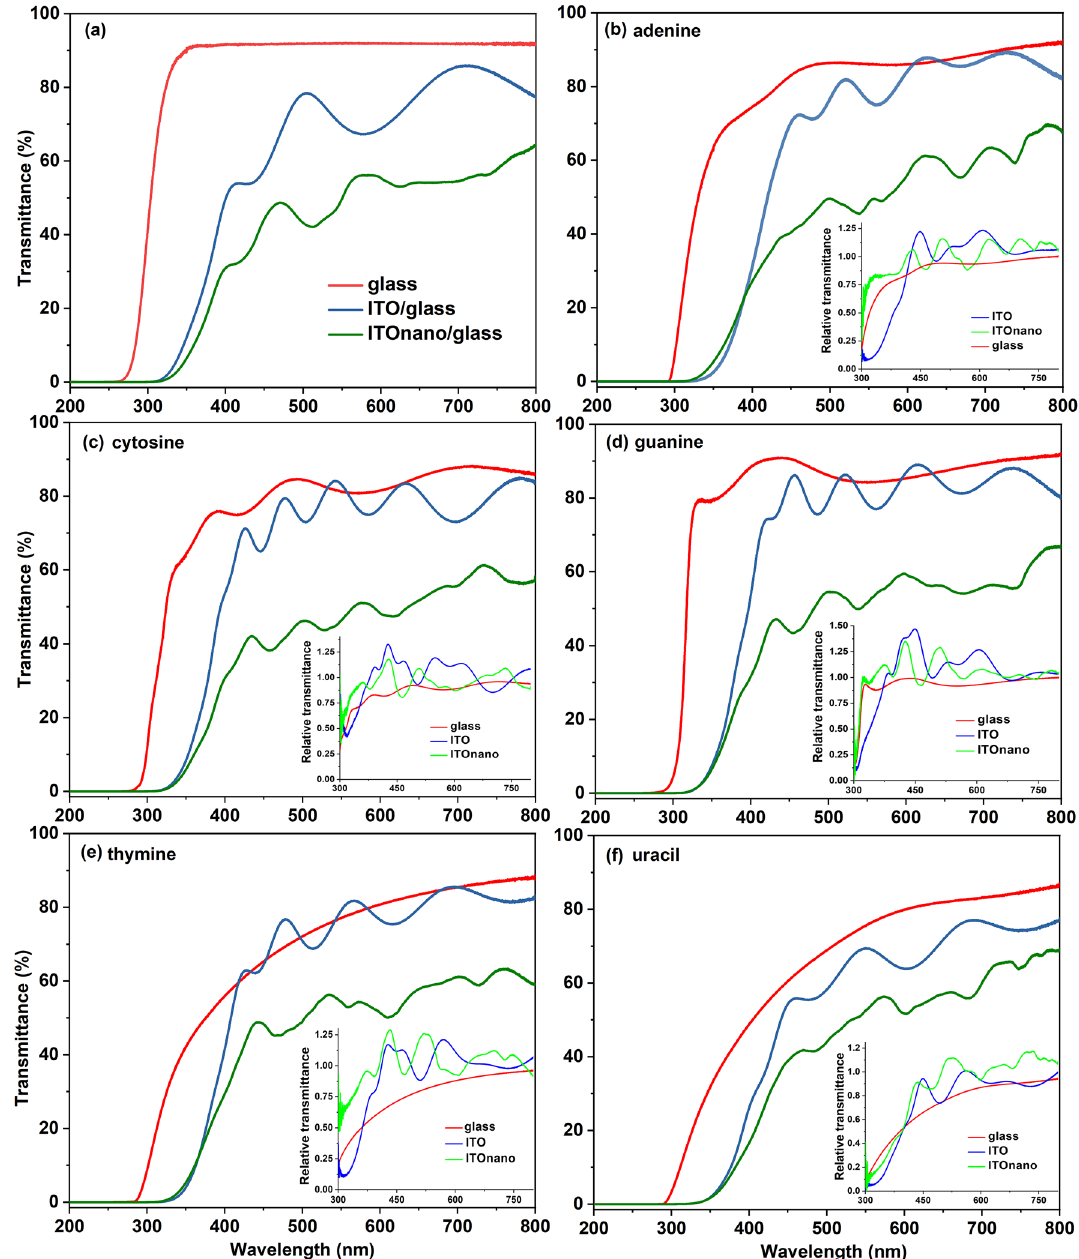
Figure 6. UV–Vis transmission spectra of the substrates ( a ) and of the nucleobases thin films deposited by VTE on them ( b – f ) with air reference. The insets represent the UV–VIS transmission spectra for the same samples with glass, ITO/glass and ITOnano/glass